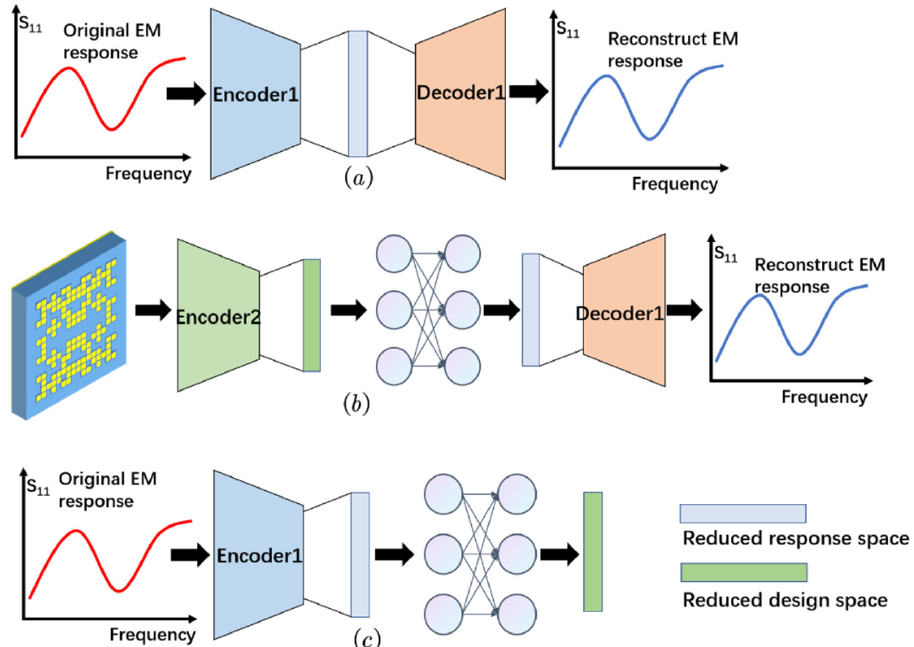
Figure 4. ( a ) Network 1, reduce the dimension of the ORS. ( b ) Network 2, used to forward prediction. ( c ) Network 3, RL module’s ultimate network.